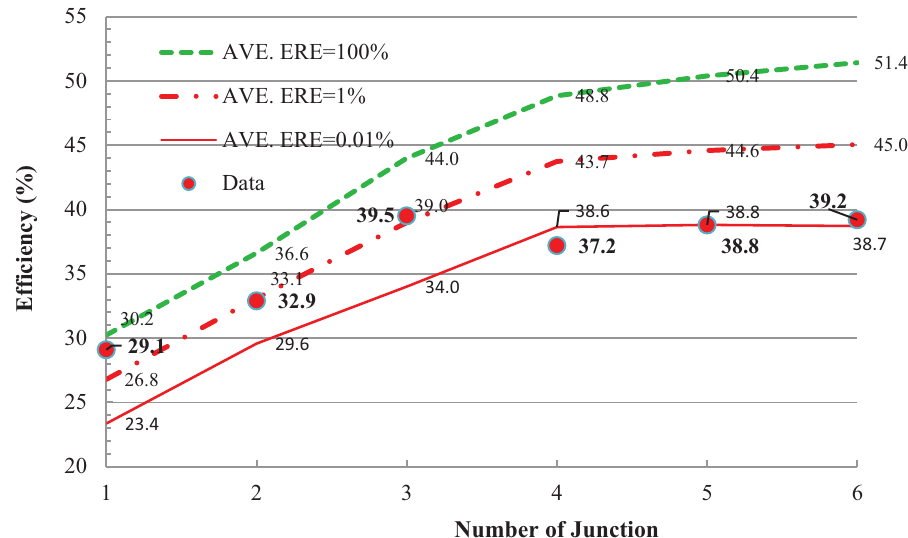
Fig. 1. Calculated ef fi ciencies of III – V compound MJ solar cells under 1-sun condition as a function of the number of junction and average external radiative ef fi ciency (ERE) [2] in comparison with ef fi ciency data (best laboratory ef fi ciencies [3]). (Reproduced with permission from Ref. [2]. Updated).